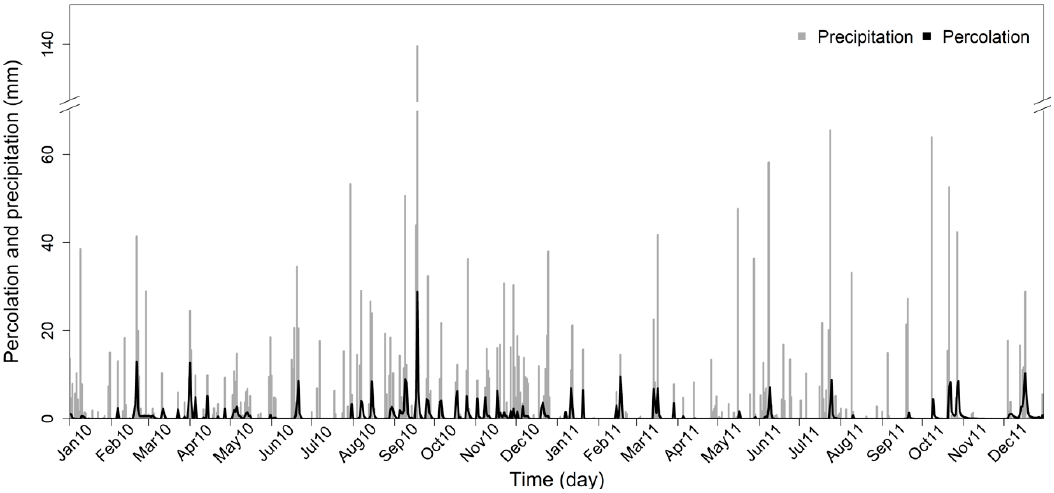
Figure 10. Daily precipitation observed in Bežigrad (mm) and percolation simulated in WaSiM (mm) for the full model domain–the Ljubljansko polje.